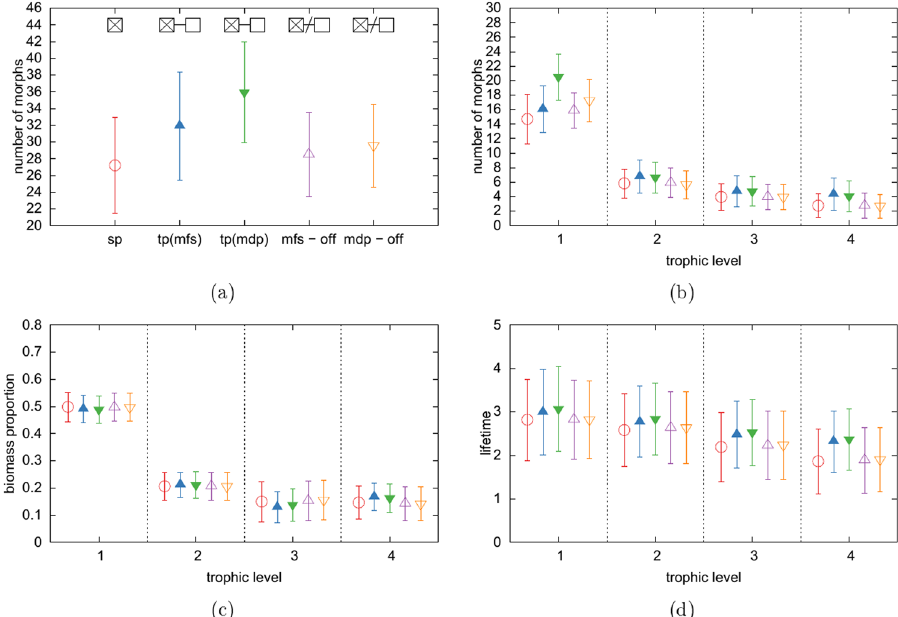
Figure 3. Properties of food webs of 5 different scenarios: single patch (sp), migration from the start (mfs), migration after a development phase (mdp) and migration switched off for the previous two scenarios. (a) Global diversity (b) Number of morphs per trophic level, as defined in Fig. 4(c) Distribution of biomass over trophic levels (d) Average lifetime, measured as decimal logarithm of the mutation events survived. Error bars correspond to standard deviations.